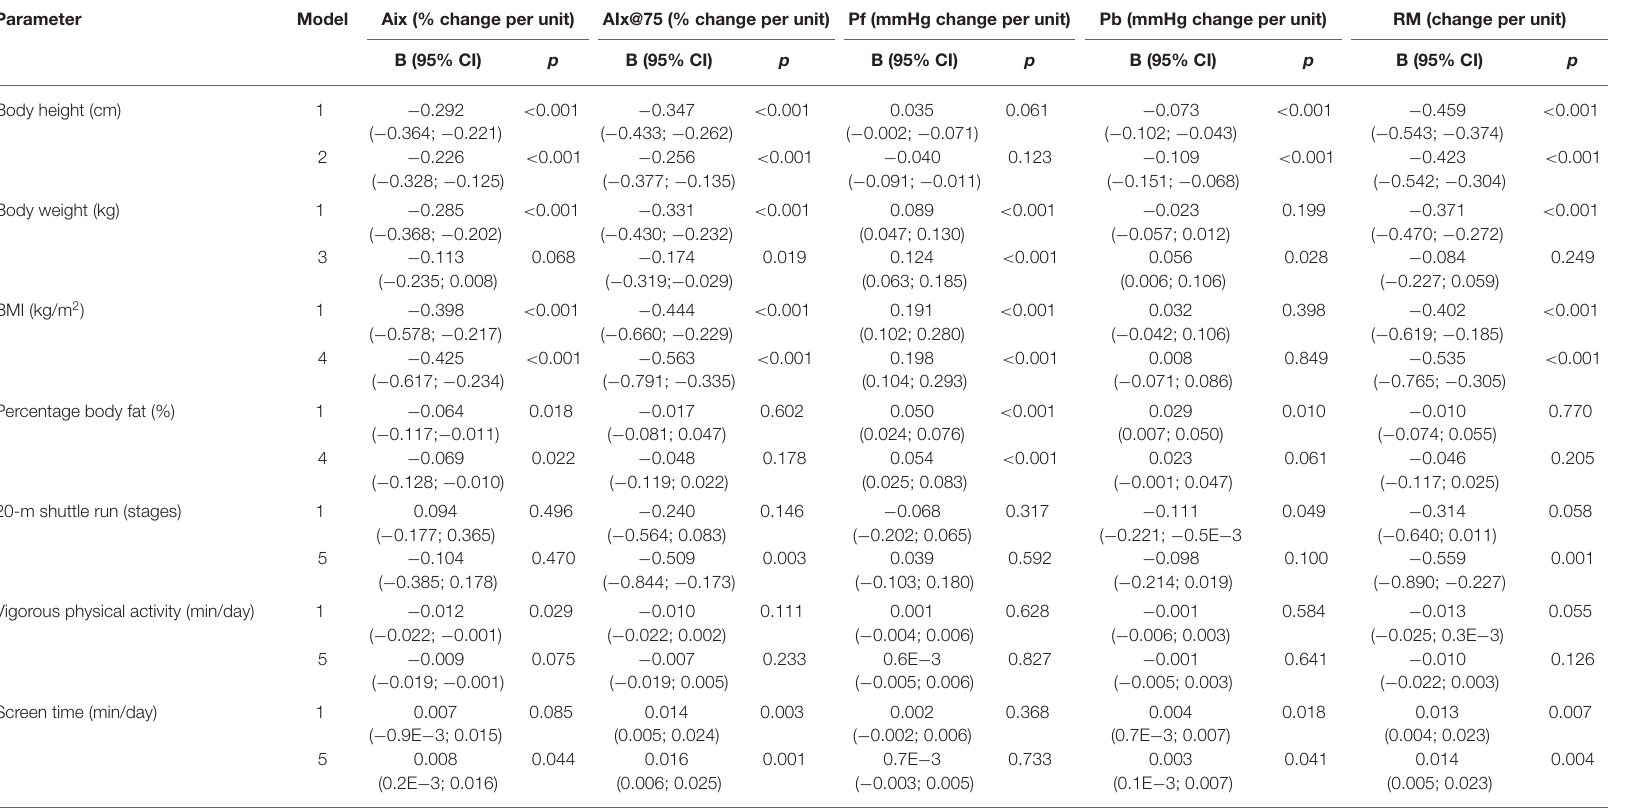
Model 1, adjusted for age and sex; Model 2, model 1 plus adjusted for body weight and shuttle run; Model 3, model 1 plus adjusted for body height and shuttle run; Model 4, model 1 plus adjusted for shuttle run; Model 5, model 1 plus adjusted for body height and body weight. BMI, body mass index; AIx, augmentation index; AIx@75, augmentation index normalized for a heart rate of 75 bpm; Pf, peak forward pressure; Pb, peak backward pressure; RM, reflection magnitude; CI, confidence